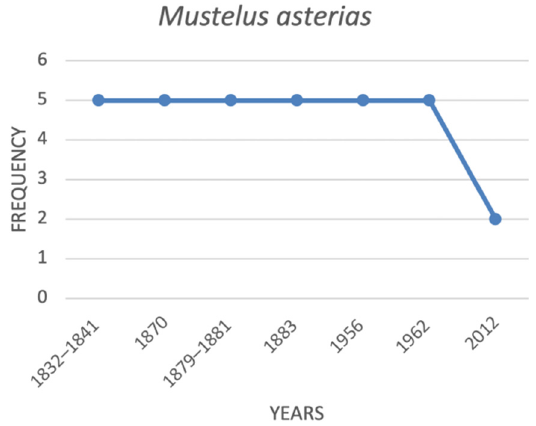
Figure 6. Temporal trend of Alopias vulpinus.